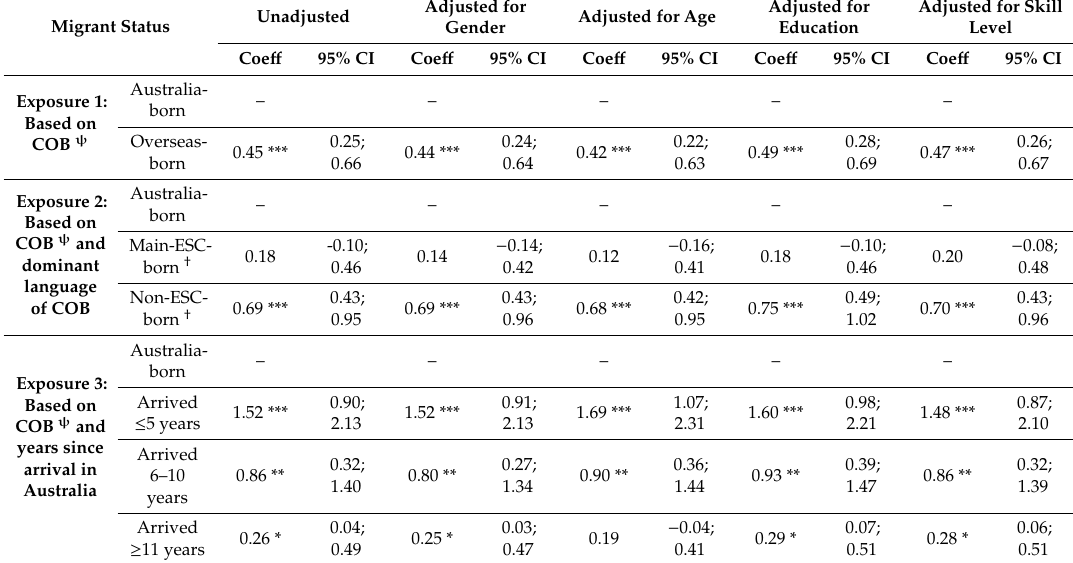
Table A1. Mean di ff erences in job insecurity between Australia-born workers and migrant workers, unadjusted and adjusted for gender, age, education attainment, and occupational skill level, separately ( n = 9043).